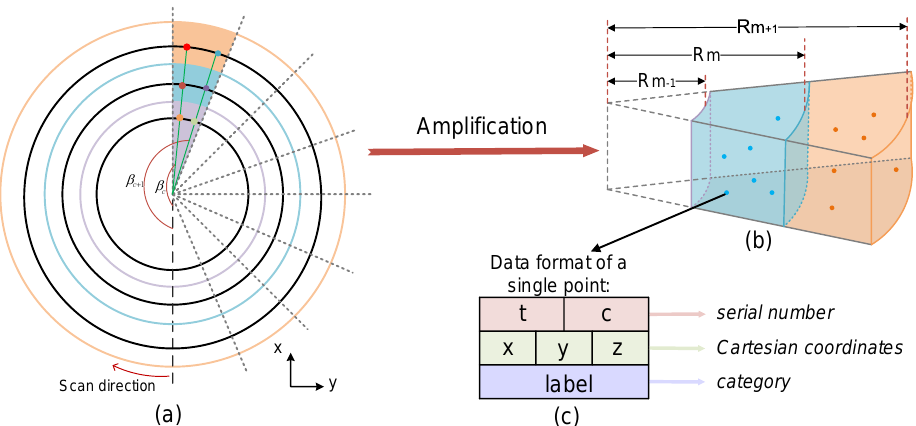
Figure 3. ( a ) The schematic diagram of the ring-shaped elevation map. The black circles represent the LiDAR scan’s ideal shape, and different colored blocks represent different cells. ( b ) The three- dimensional display of the adjacent cells and the corresponding stored points. R m is the radius of the grid ( m , n ) . ( c ) The data form of a single point. t , c are the serial number; x , y , z are the Cartesian coordinates; and label is the category.